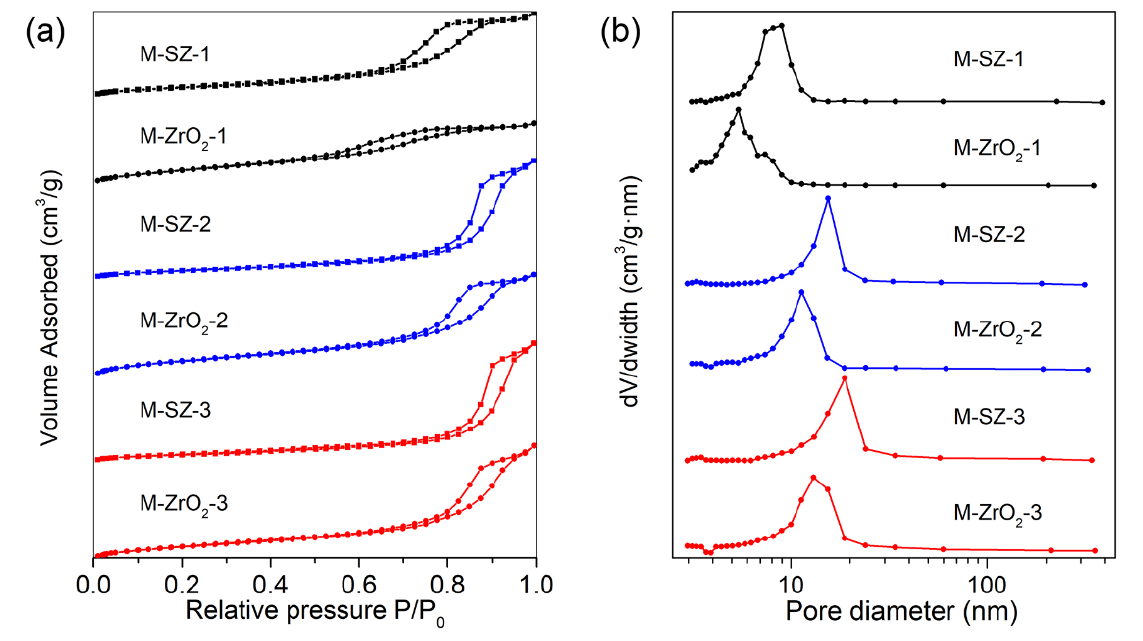
Figure 4. ( a ) N 2 adsorption–desorption isotherms and ( b ) pore distribution of M-ZrO 2 -1, M-ZrO 2 -2, M-ZrO 2 -3, M-SZ-1, M-SZ-2, and M-SZ-3. Table 1. The specific surface area, pore volume, and pore diameter of the samples. BET Surface Samples